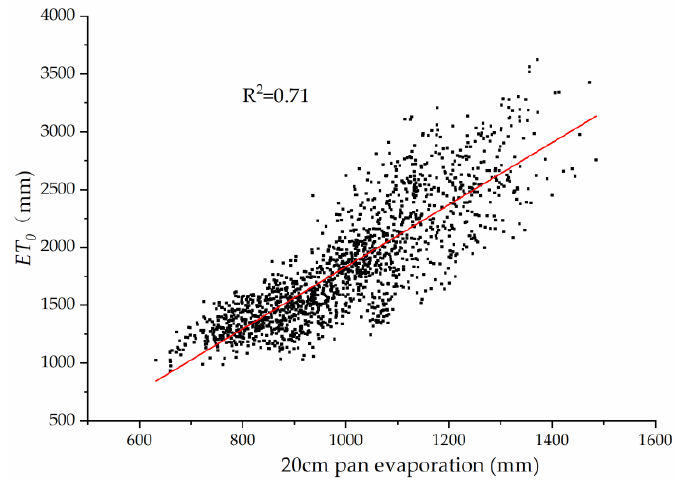
Figure 2. The relationship between P-M ET 0 and the 20 cm pan evaporation.